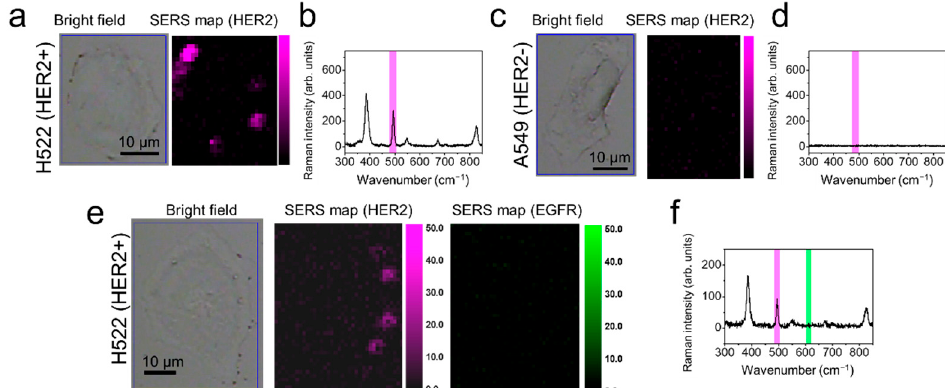
Figure 5. Extracellular human epidermal growth factor-2 (HER2)-specific detection of lung cancer cells (H522 and A549 cells). ( a ) H522 cells were treated with HER2-Ag NGSs [2-FBT] particles. Bright-field image of H522 cells and a SERS intensity map corresponding to ( b ) a band at 494 cm − 1 (HER2-Ag NGSs [2-FBT] , purple). ( c ) A549 cells treated with HER2-Ag NGSs [2-FBT] were used as a negative control. Bright-field image of A549 cells and a SERS intensity map corresponding to ( d ) a band at 494 cm − 1 , obtained using an excitation wavelength of 785 nm, a laser power of 7.5 mW, and a light-acquisition time of 1 s. ( e ) H522 cells were treated with a mixture of HER2-Ag NGSs [2-FBT] and epidermal growth factor receptor (EGFR)-Ag NGSs [4-FBT] particles. Bright-field image of H522 cells and SERS intensity maps corresponding to ( f ) bands at 494 cm − 1 (purple) and 623 cm − 1 (green).